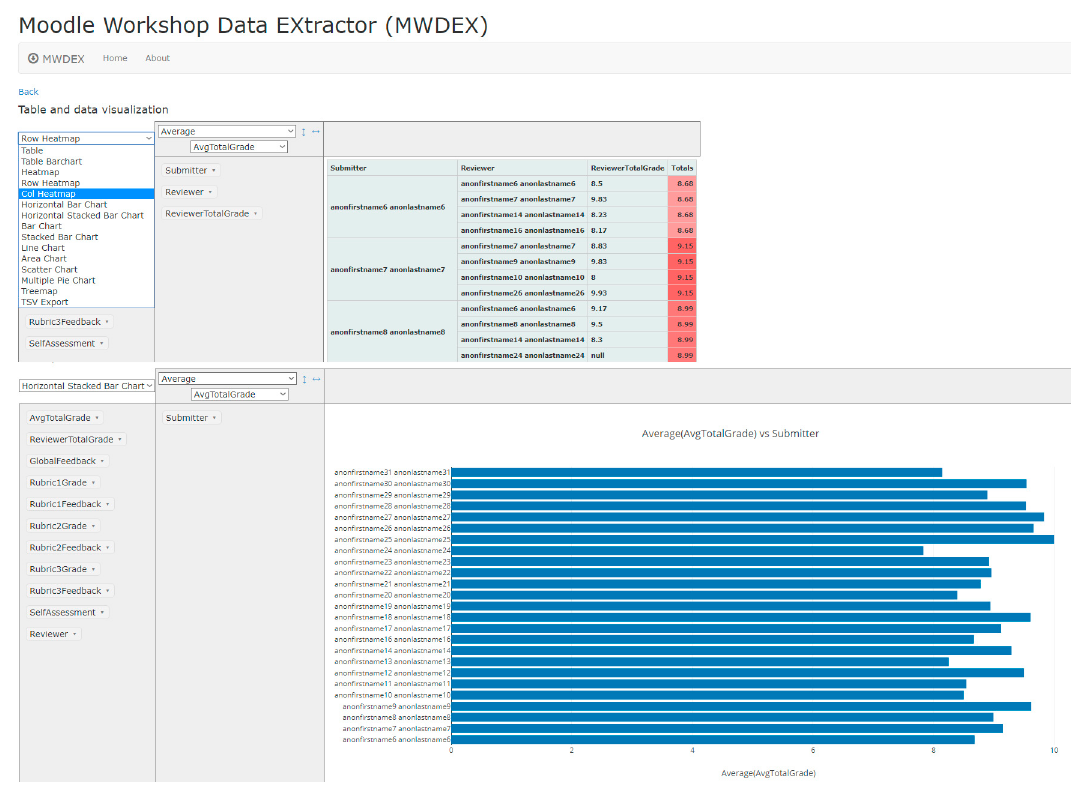
Figure 10. Interactive data visualization and charts of MWDEX. Appl. Sci. 2020 , 10 , x FOR PEER REVIEW